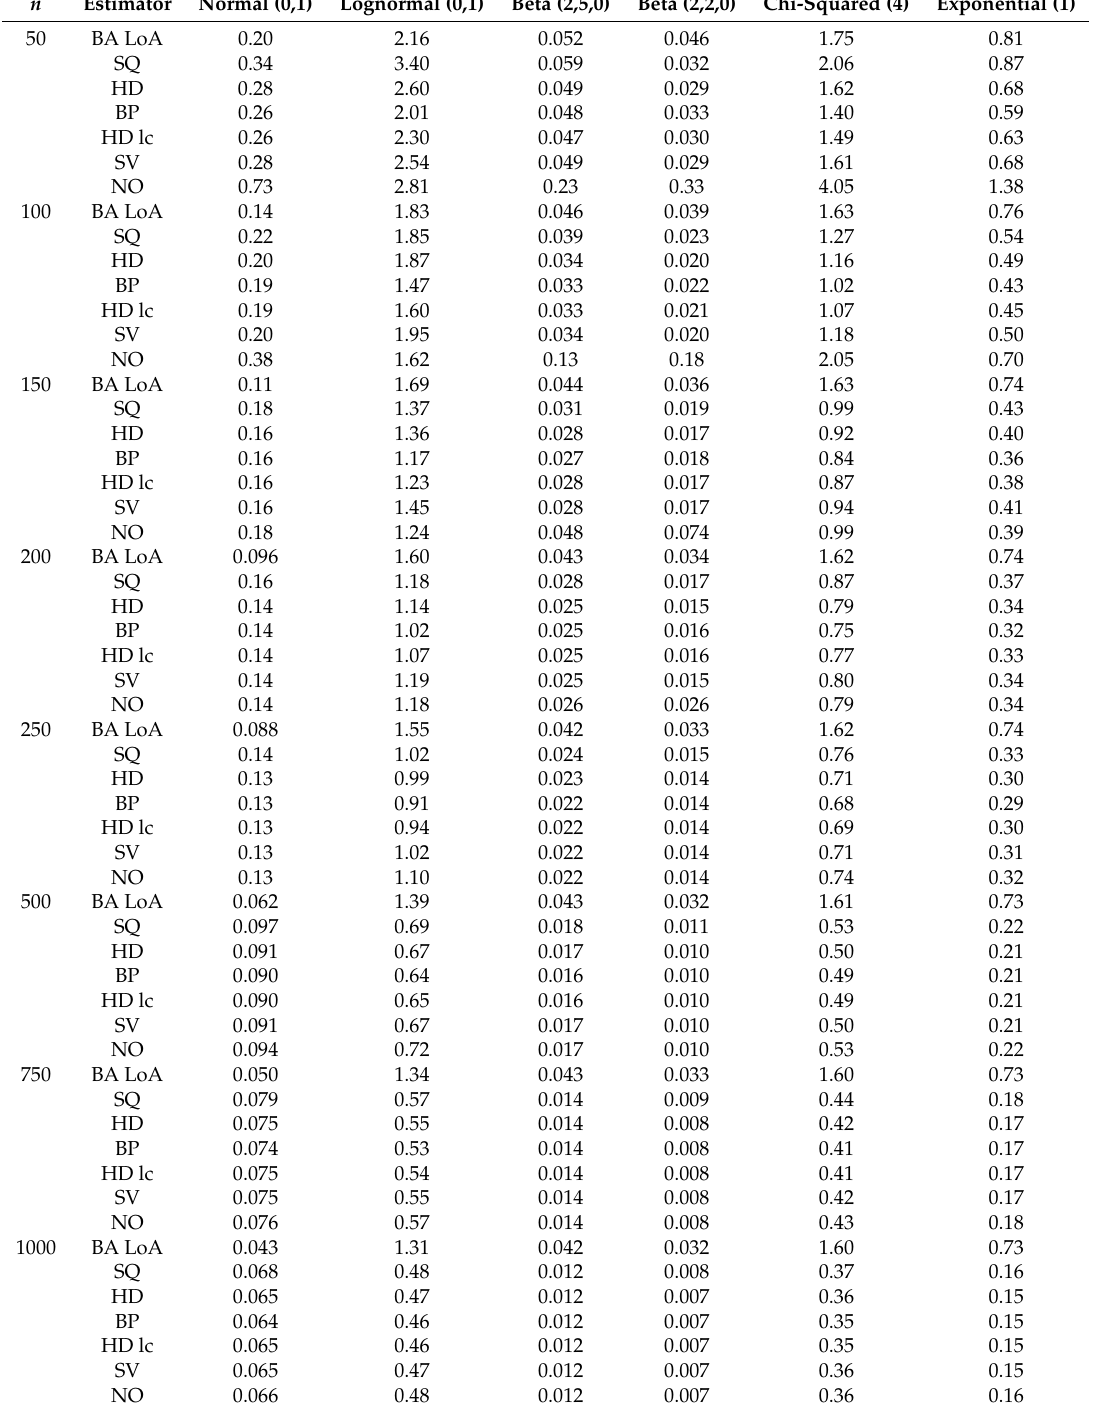
Table 3. RMSE of the estimated 97.5% quantiles by sample size, estimator, and distribution.